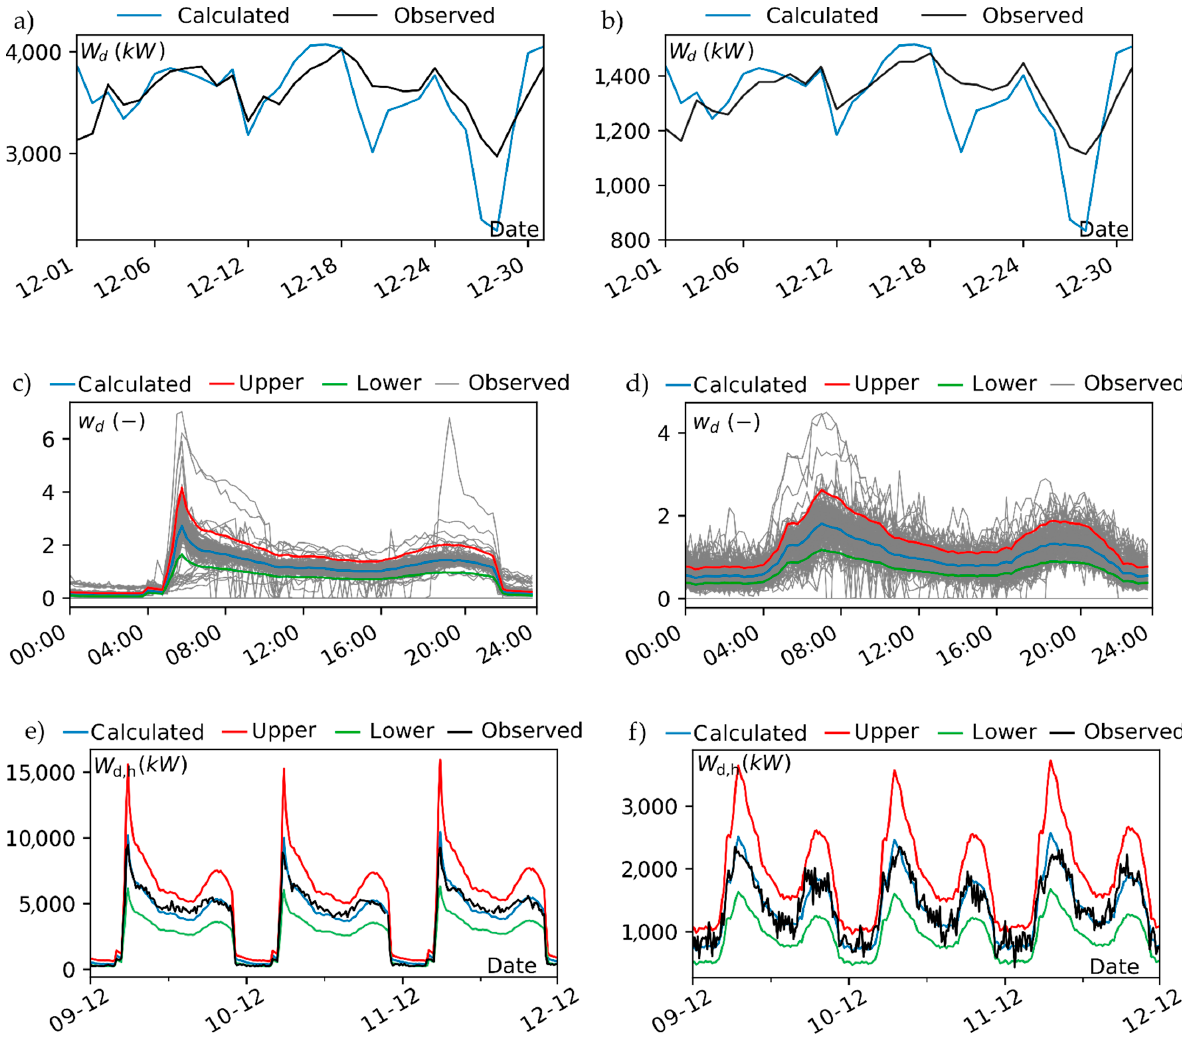
Figure 9. District heat load forecasting of users 51 and 56 belonging to group 1 and 2, respectively. ( a , c , e ) concerns user 51, while ( b , d , f ) user 56. ( a , b ) show the plot of the seasonal component, ( c , d ) indicate the intra-daily patterns of the heating season with the mean and boundaries (5th and 95th percentiles, respectively), and ( e , f ) describe the final heat load prediction of three days.